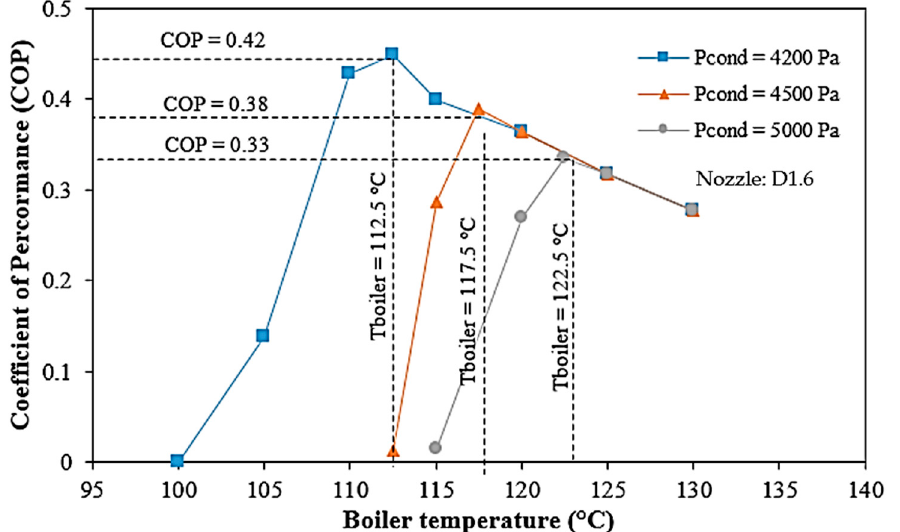
Figure 7. The optimal performance affected by the condenser pressure.